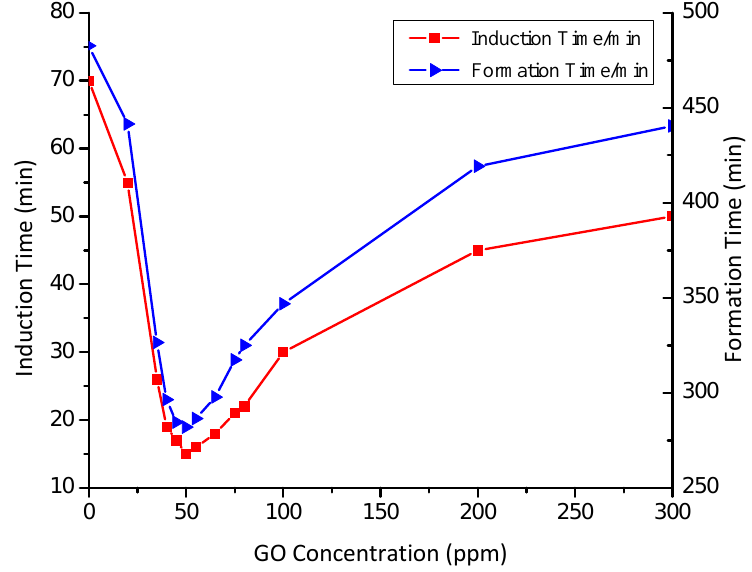
Figure 9. The effect of GO concentrations on introduction time and formation time.